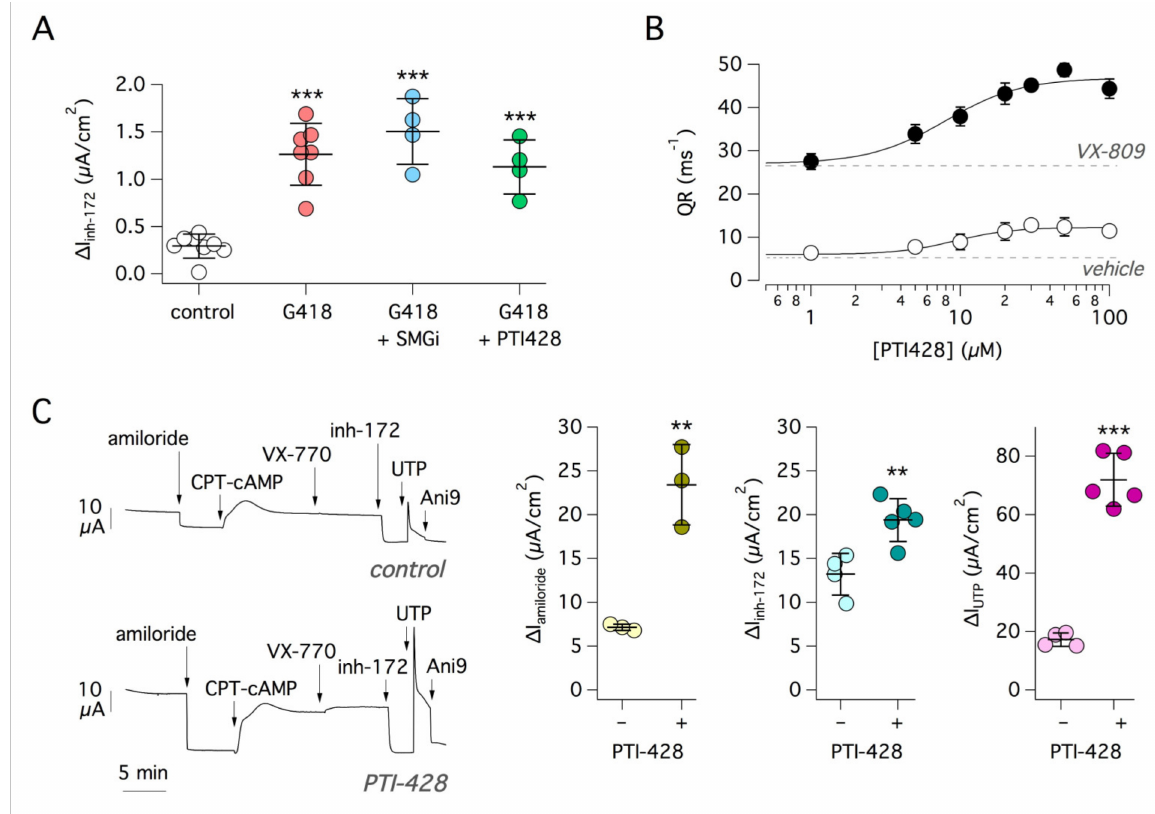
Figure 2. Functional analysis of PTI-428 and SMG1i. ( A ) The scatter dot plot reports CFTR function (i.e., current sensitive to inh-172) in 16HBE14o- cells expressing G542X-CFTR treated for 24 h with G418 (0.5 mg/mL) alone or in combination with SMG1i (1 µ M) or PTI-428 (30 µ M). SMG1i and PTI-428 appear ineffective under these conditions. ***, p < 0.001 vs. control. ( B ) Rescue of F508del-CFTR function by PTI-428. CFBE41o- cells expressing F508del-CFTR were treated for 24 h with the indicated PTI-428 concentrations, in the presence of absence of VX-809 (1 µ M). Data (quenching rate, QR), obtained with the HS-YFP assay, were fitted with a Hill function. Dashed lines indicate the activity with VX-809 or vehicle alone. ( C ) Representative traces (left) show Ussing chamber experiments done on non-CF primary bronchial epithelial cells. Cells were treated for 24 h with the CFTR amplifier PTI-428 (30 µ M) or vehicle (DMSO) alone. During recordings, the function of three channels was evaluated: (i) for the epithelial Na + channel (ENaC), we measured the amplitude of amiloride (10 µ M) effect; (ii) for CFTR function, we measured the effect of inh-172 after maximal stimulation with CPT-cAMP; (iii) for the activity of the Ca 2+ -activated Cl − channel TMEM16A, we measured the maximal amplitude of the current elicited with UTP (100 µ M). Ani9 (5 µ M) was added to inhibit TMEM16A at the end of the experiments. The scatter dot plot (right) reports the function of ENaC, CFTR, and TMEM16A in cells treated with PTI-428 or vehicle. **, p < 0.01; ***, p < 0.001 vs.